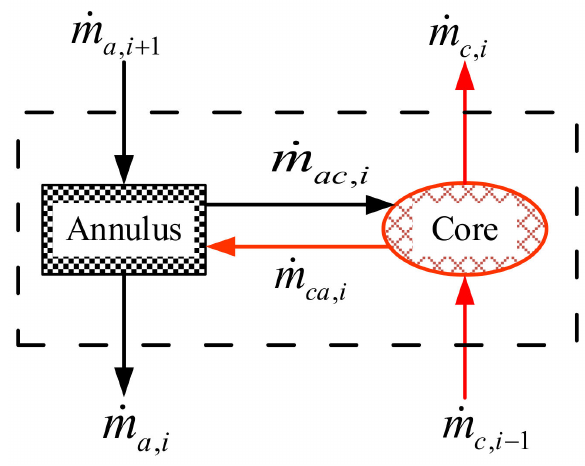
Figure 7. Mass balance of the node i